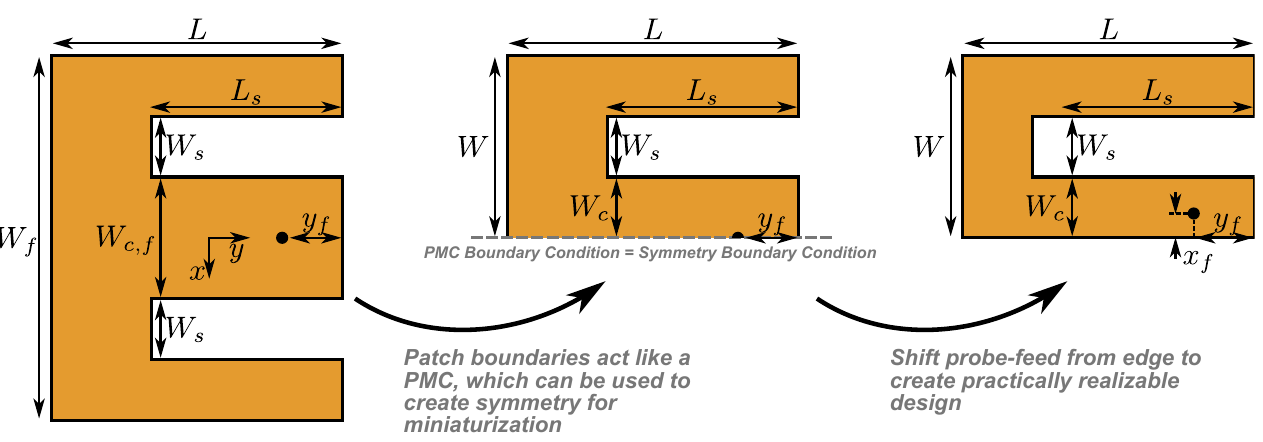
FIGURE 11. Illustration on how to achieve miniaturization in the linearly-polarized E-shaped patch antenna. The Half E-shaped patch gains roughly 50% size reduction compared to the original linearly-polarized E-shaped